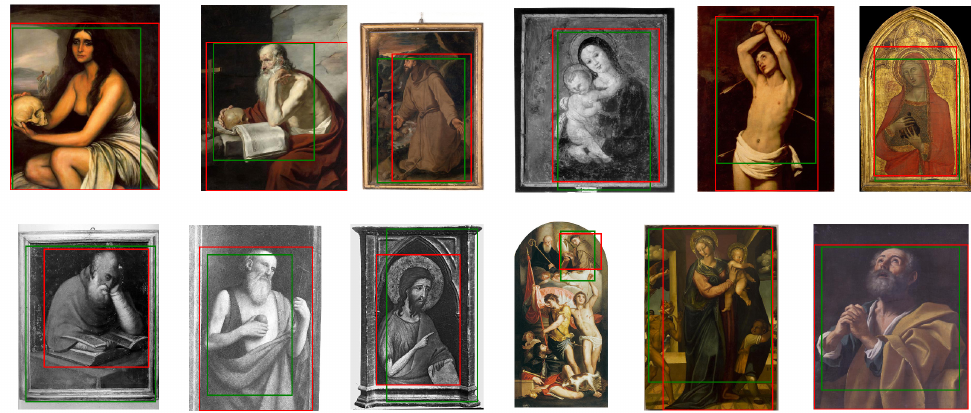
Figure 20. Examples of Saints bounding boxes generated from Grad-CAM (green) and manually annotated